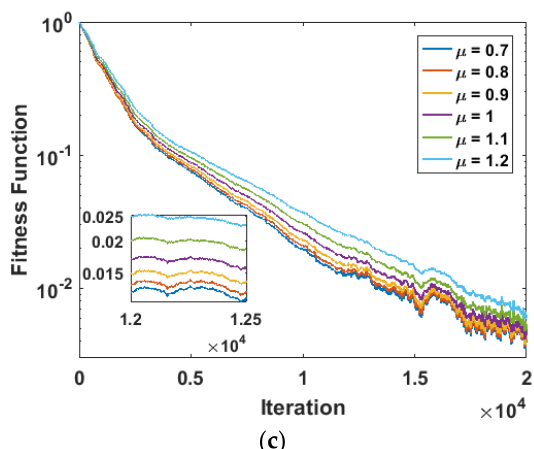
Figure 3. Learning curves of the HQFGD for different fractional orders. ( a ) σ = 0.02; ( b ) σ = 0.09; ( c ) σ = 0.2.